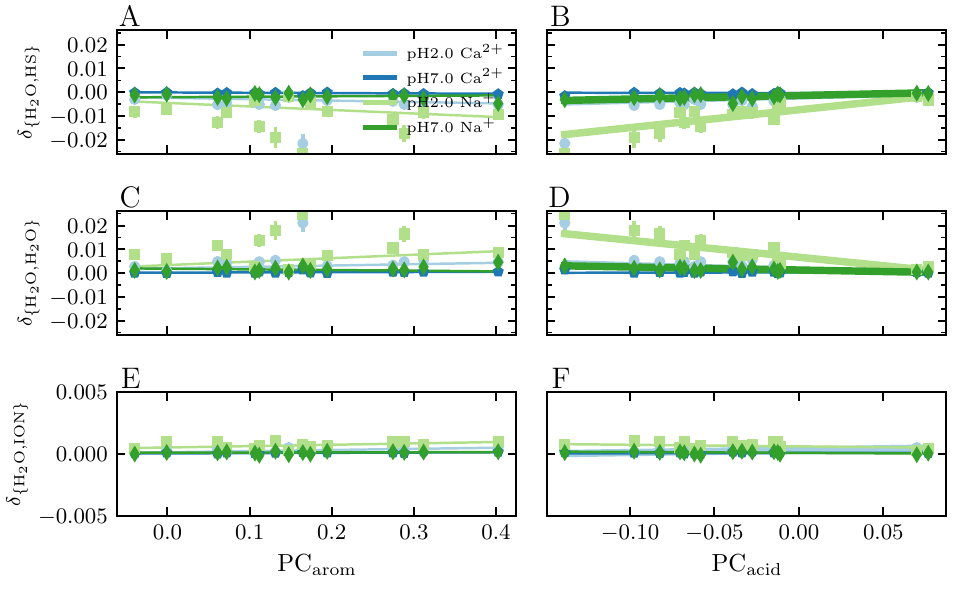
Figure 7. Preferential solvation of water molecules with different species (HS, H 2 O and Ca 2 + ) of the standard humic substances models. Plots show the preferential solvation with ( A , B ) the humic substances, ( C , D ) water and ( E , F ) cations (calcium or sodium) in function of their PC arom and PC acid . Each point represents the average over four independent simulations with error bars representing the standard error. Notice the different y -axis scales in these